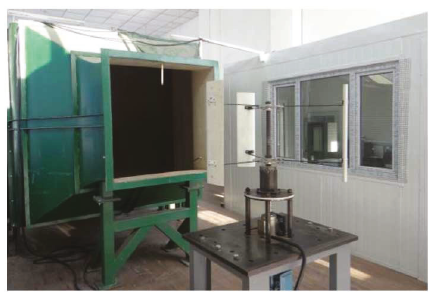
Figure 7: Physical diagram of experimental system.